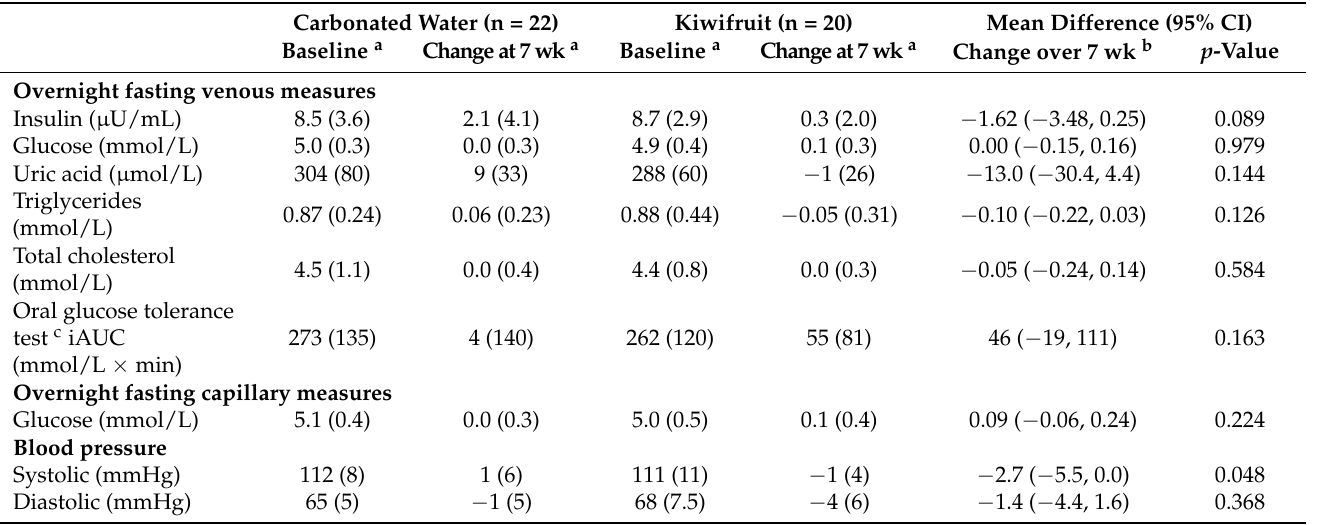
Table 3. Effect of daily consumption of kiwifruit compared with carbonated water on metabolic outcomes (n =